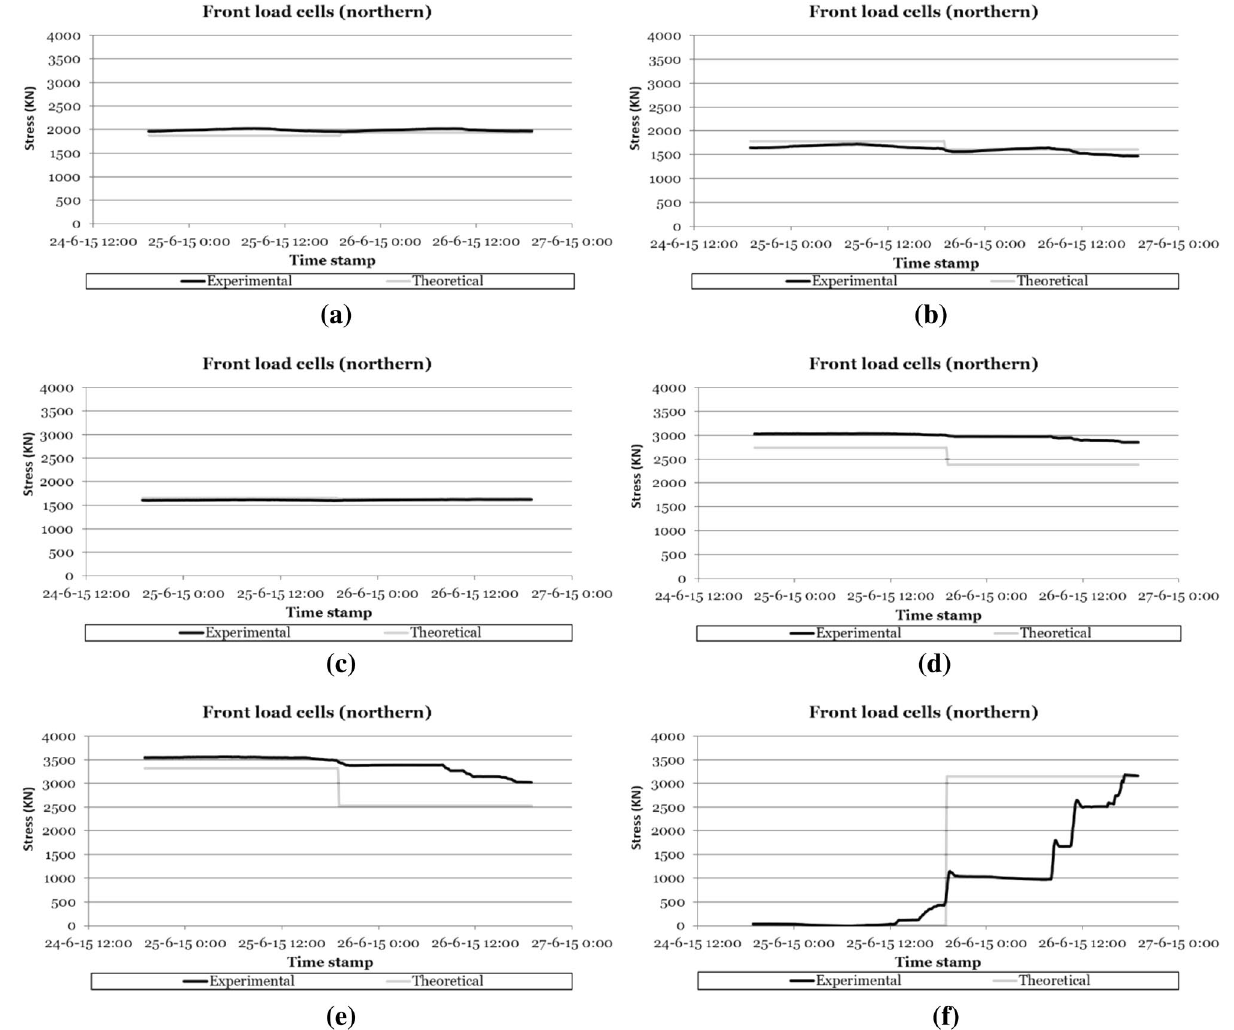
Figure 5. Recording the evolution of stresses in the stay cables of the northern semi-arch during tensioning of the thirteenth cable family: ( a ) 3rd cable family; ( b ) 5th cable family; ( c ) 7th cable family; ( d ) 9th cable family; ( e ) 11th cable family; ( f ) 13th cable